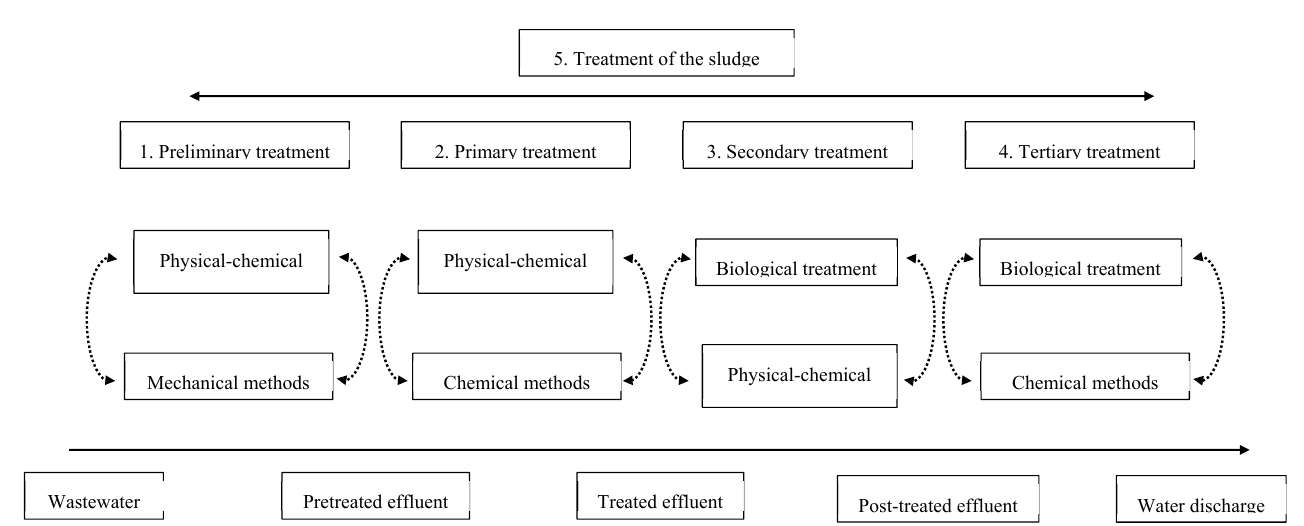
Figure 1. Main processes for the decontamination of wastewater (adapted by [7]).